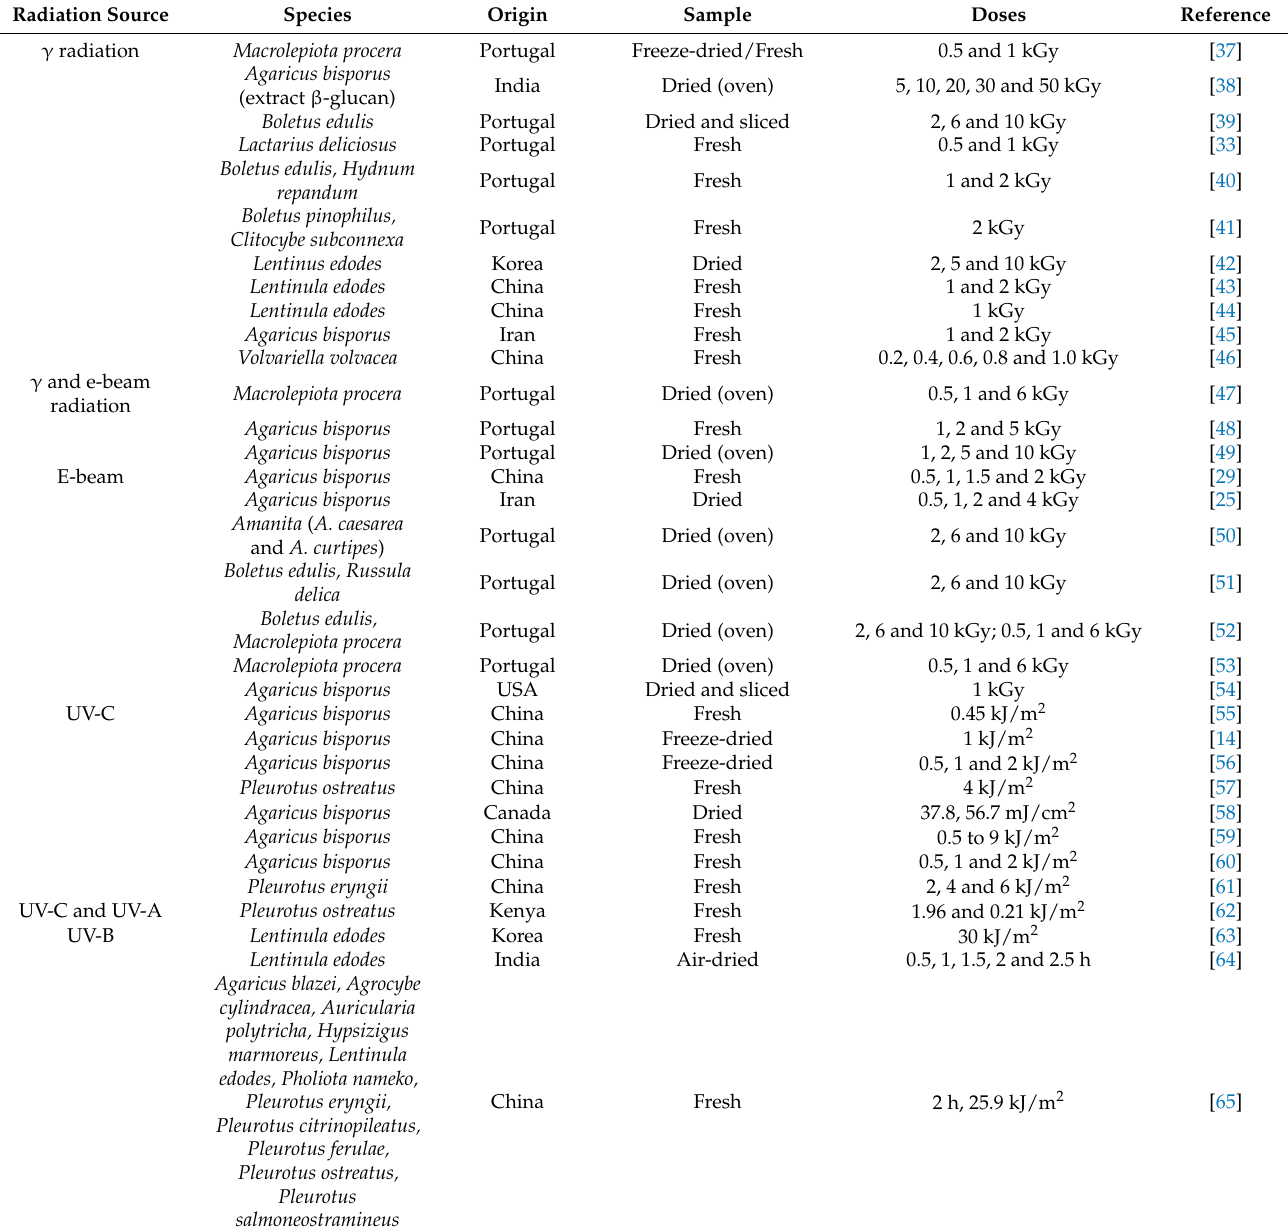
Table 1. Irradiated edible fungal species and irradiation